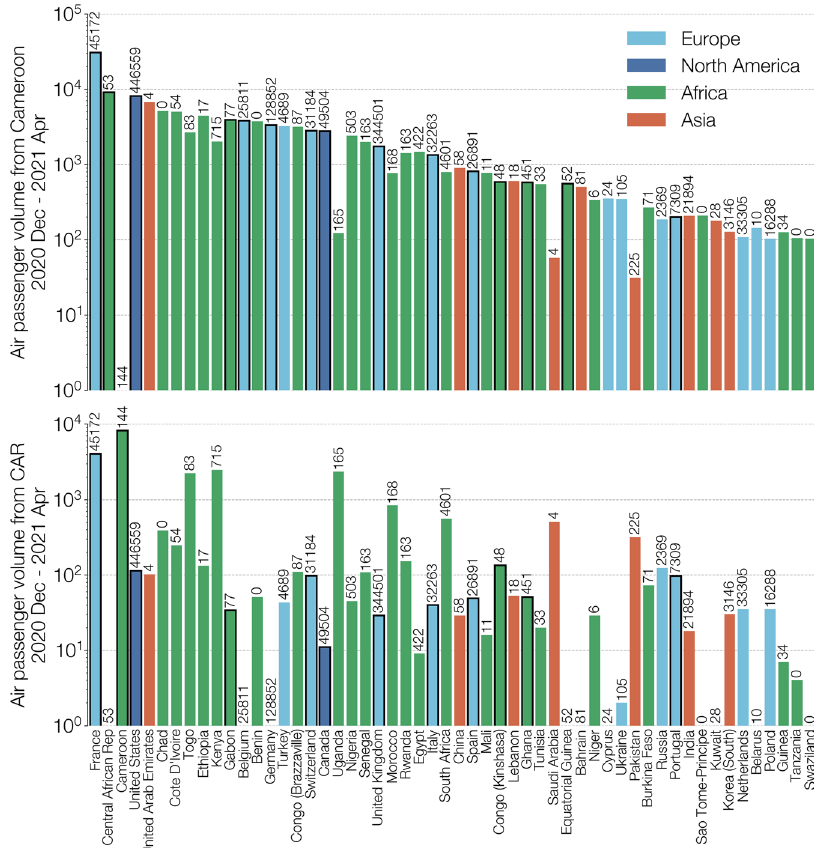
Fig. 5 Total air passenger fl ows out of Cameroon (top) and Central African Republic (bottom) between December 2020 and April 2021. Destination countries are sorted by total passenger volume arriving from Cameroon and Central African Republic (CAR) combined, coloured by continent (Europe in light blue, North America in dark blue, Africa in green, and Asia in red) and limited to countries where at least 100 passengers have arrived from either Cameroon or CAR between December 2020 and April 2021. Note the nearly order of magnitude greater passenger fl ux out of Cameroon compared to the Central African Republic (CAR). Numbers above each country ’ s bar indicate the total number of genomes on GISAID from that country since January 1st 2021, according to GISAID ’ s 2021-07-02 metadata release. Bars outlined in black represent countries that have submitted at least one B.1.620 genome as of June